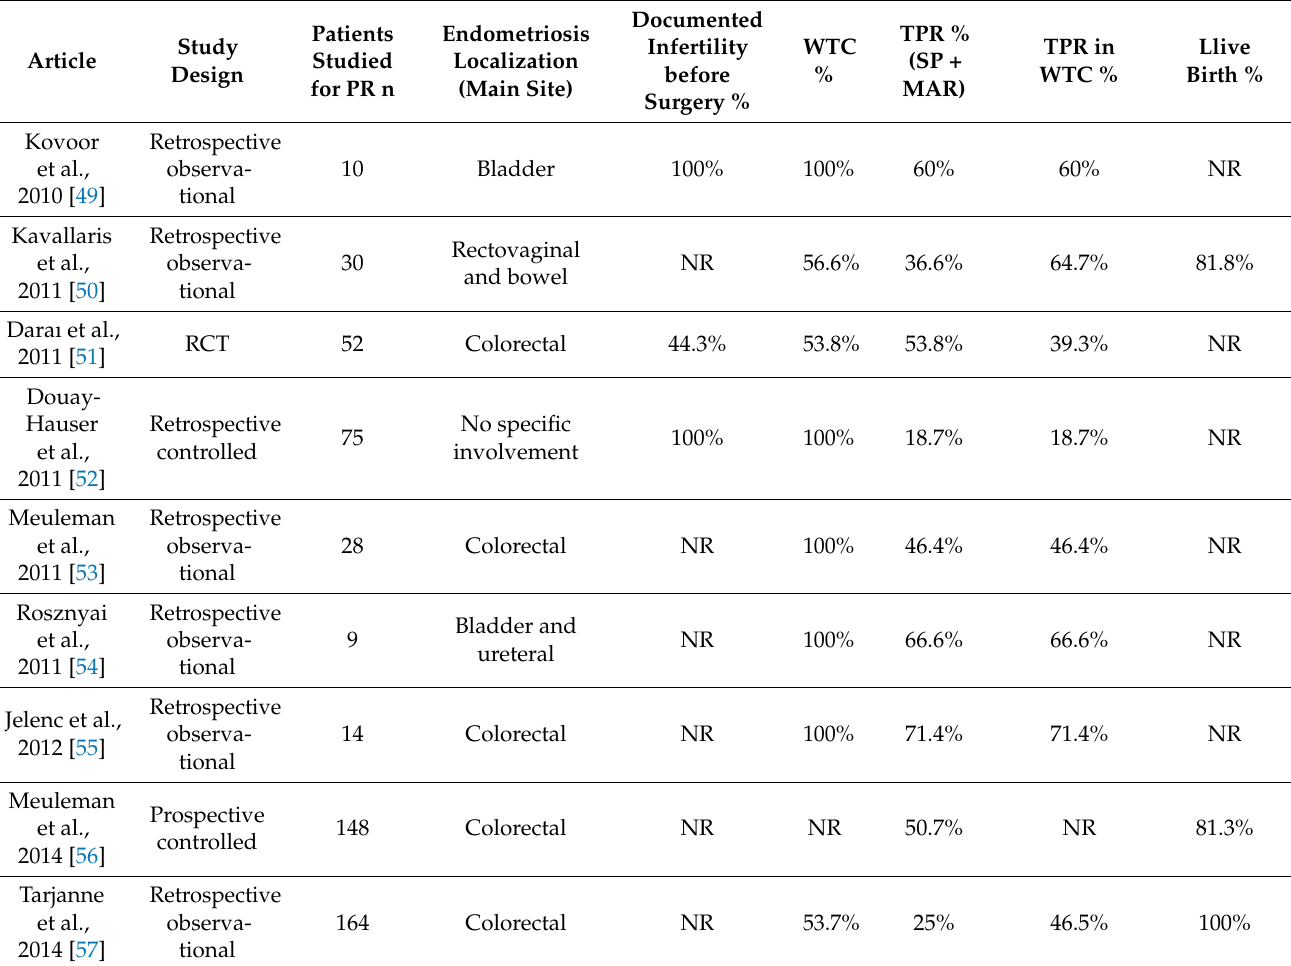
Table 1. Main characteristics of considered studies and fertility outcomes after surgery for deep endometriosis: spontaneous and